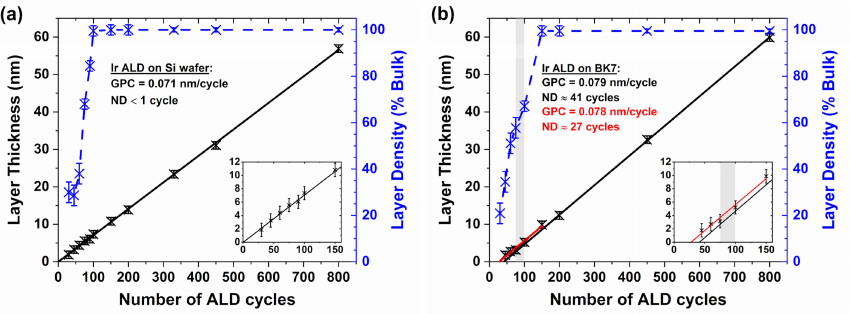
Figure 4. Layer thickness and layer density of Ir coatings depending on the number of ALD cycles on ( a ) Si wafers and ( b ) BK7. In certain regions, the film growth is fitted linear (black and red lines). The corresponding growth per cycle (GPC) and nucleation delay (ND) are indicated. For BK7, a gray background highlights the region of Ir layer percolation.